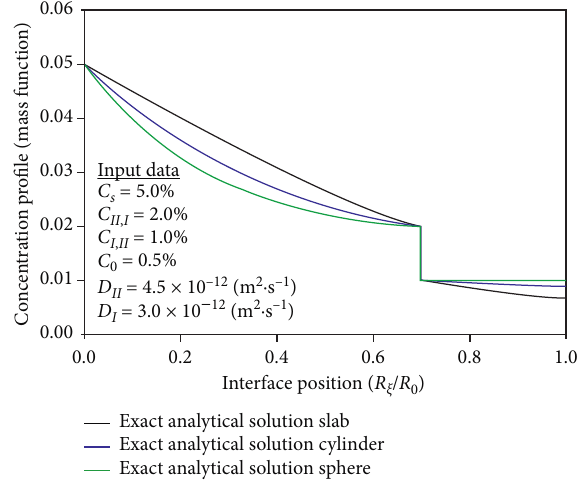
Figure 17: Comparison between numerical and analytical solu- tions for times during inward two-phase solidification of a slab, a cylinder, and a sphere.